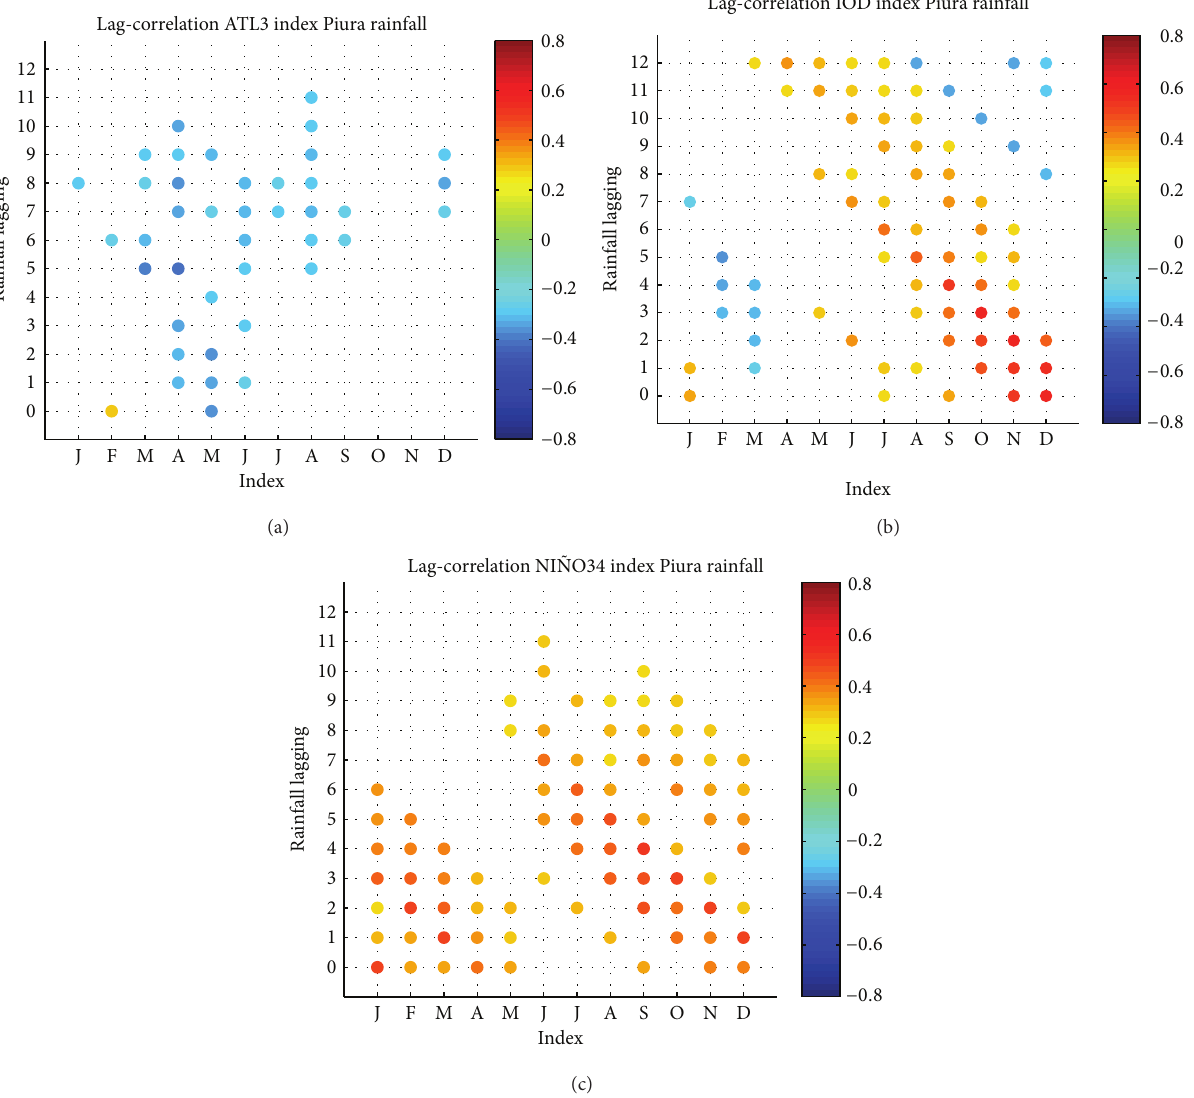
Figure 5: Monthly correlations between the (a) ATL3, (b) IOD, and (c) Ni˜no3.4 indices and the NWPR index from 0 to 12 months lagged.